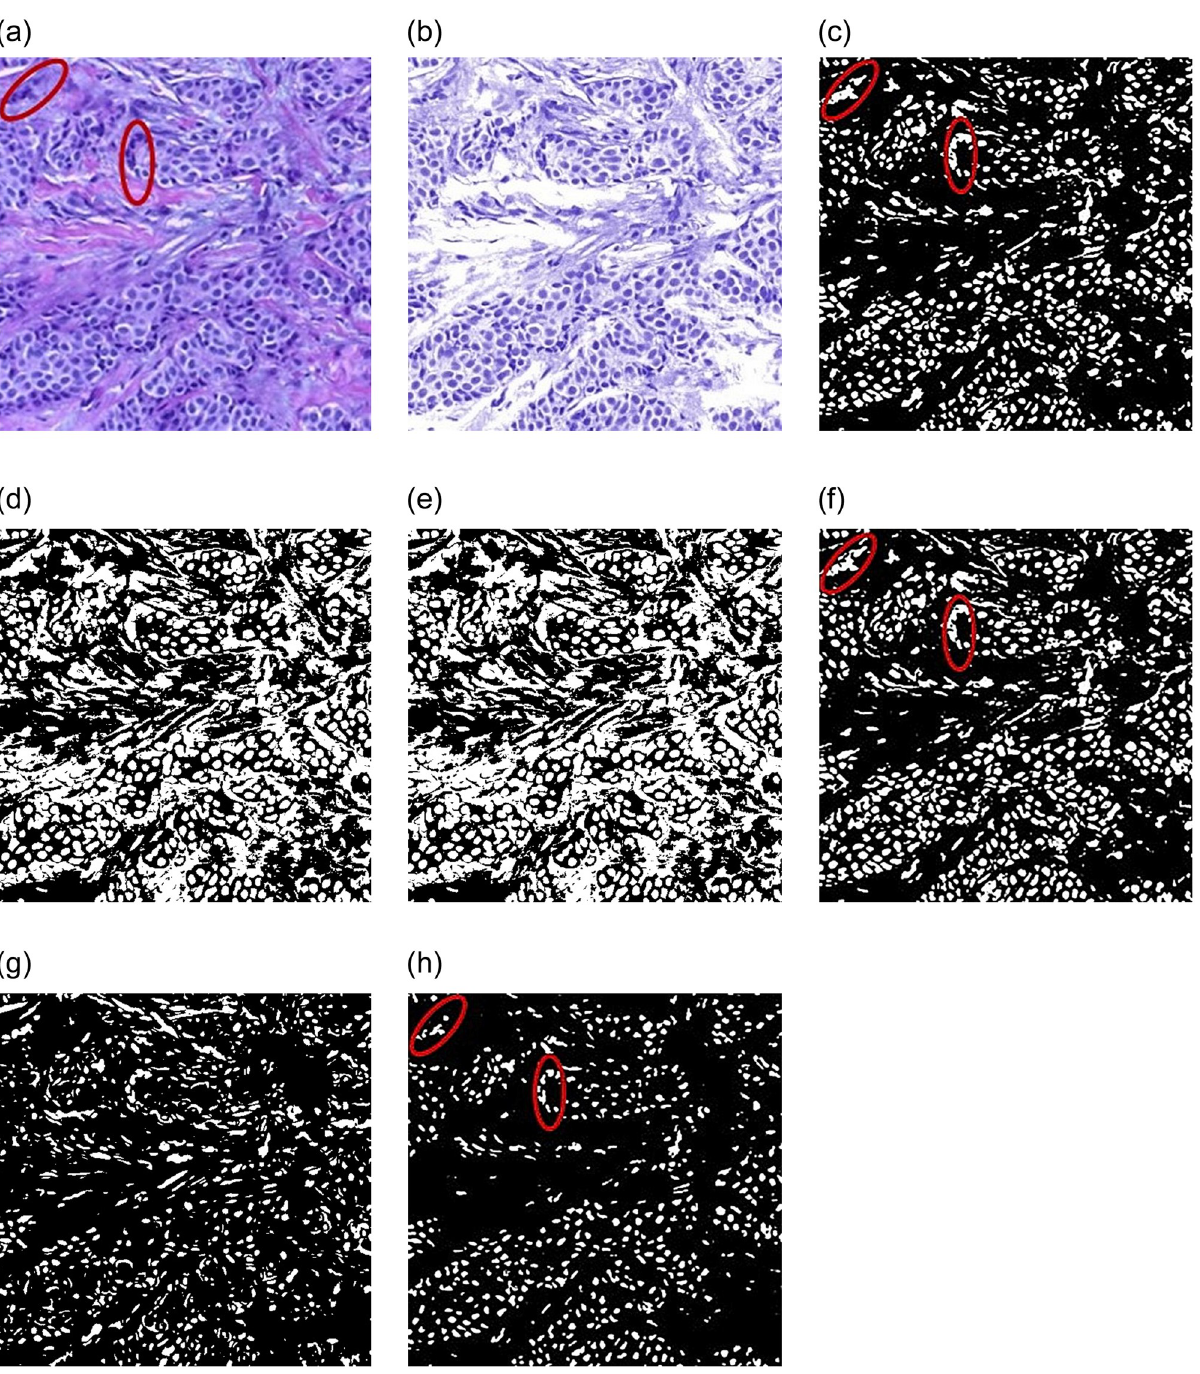
Fig 6. Results of different segmentation methods. (a) Original image, (b) Stain separation image, (c) k-means clustering segmentation, (d) Ostu threshold segmentation, (e) Iterative threshold segmentation, (f) Minimum error threshold segmentation method, (g) Watershed segmentation directly used for the original image, (h) Two-stage segmentation